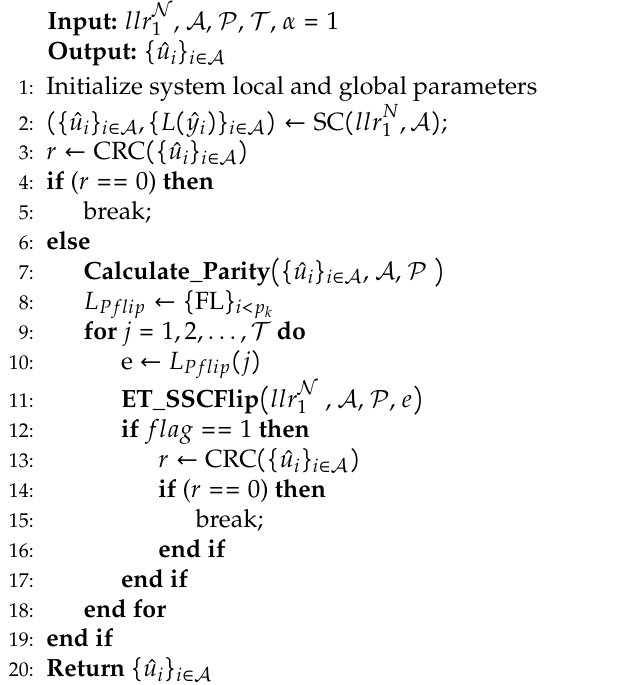
Algorithm 1 Single bit flipping PC-CRC-SSCFlip